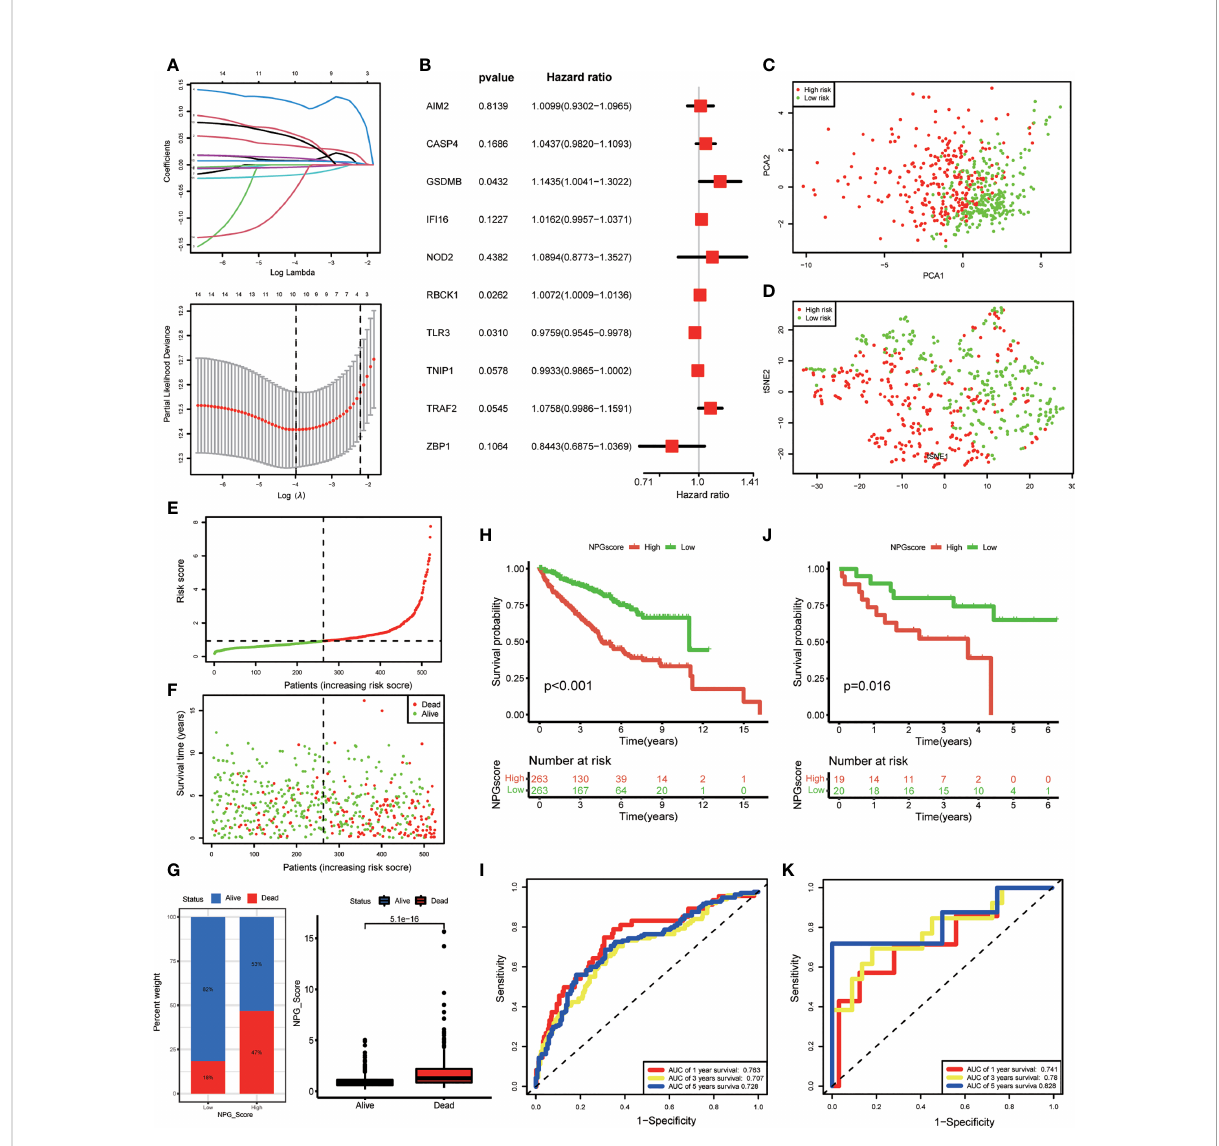
FIGURE 3 NPG prognostic model construction and validation. (A) Cross-veri fi cation for fi ne-tune the selection of parameters in LASSSO regression and 10 NPRGs were obtained in TCGA cohort for the NPG prognostic model construction. (B) Multivariate Cox regression analysis of NPRGs for NPG score calculation in TCGA cohort. (C, D) PCA map and t-SNE plots for high- and low- risk groups based on the NPG score (red dot, high risk class; green dot, low risk class). (E, F) risk plot of NPG score The survival rate (low-NPG score group: on the left side of the dotted line; high-NPG score group: on the right side of the dotted line) and time (red dot, dead subjects; green dot, alive subjects) for each patient in TCGA cohort. (G) Correlation of NPG score and vital status of ccRCC patients. (H) Kaplan – Meier curves for comparison of NPG score risks between low-NPG score and high-NPG score groups in TCGA cohort. (I) ROC curves with the NPG score prediction ef fi ciency in TCGA cohort. (J) Kaplan – Meier curves for comparison of NPG score risks between low-NPG score and high-NPG score groups in external validation cohort (GEO cohort). (K) ROC curves with the NPG score prediction ef fi ciency in external validation cohort (GEO